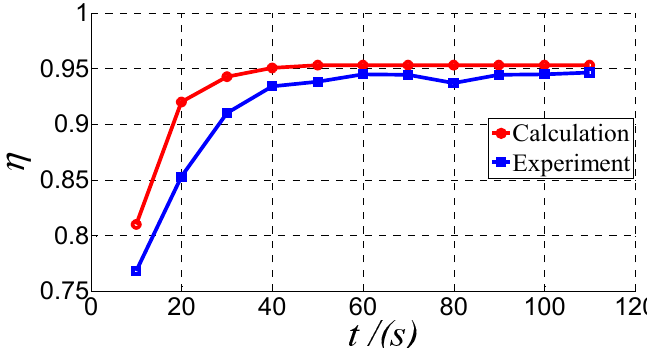
Figure 18. Calculation and experimental results of the coupling coils efficiency.